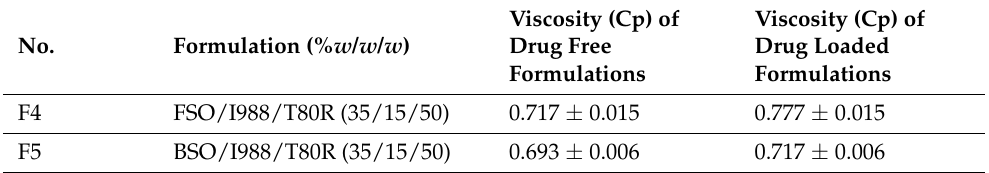
Table 7. Viscosity (Cp) determination of the drug-free and drug-loaded anhydrous formulation systems and bio-SNEDDS. Data are expressed as mean ± SD, n = 3.